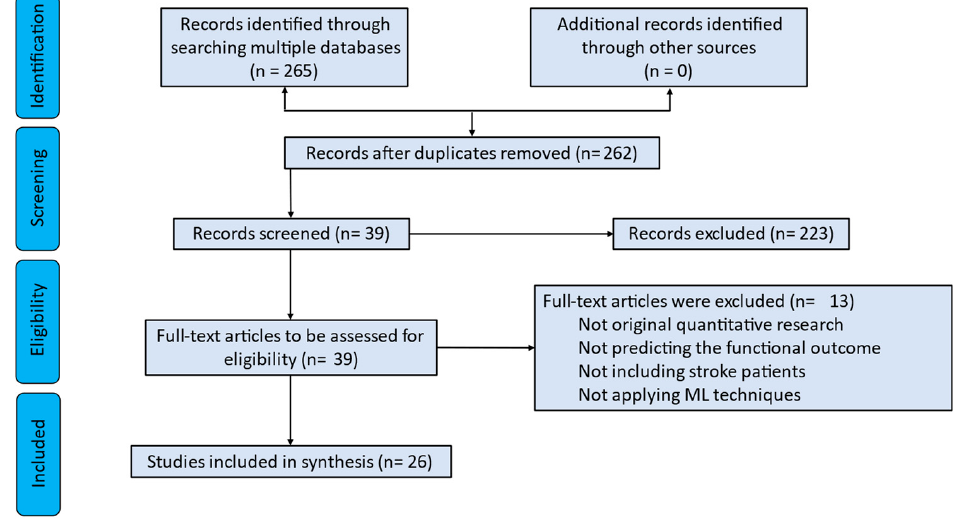
Figure 1. Workflow diagram of screening methodology. All the identified studies used ML techniques in order to predict functional outcomes in the rehabilitation of post-stroke patients. Studies that (i) applied traditional statistical approaches, (ii) did not include stroke patients (or stroke survivors), or (iii) did not perform original quantitative research were